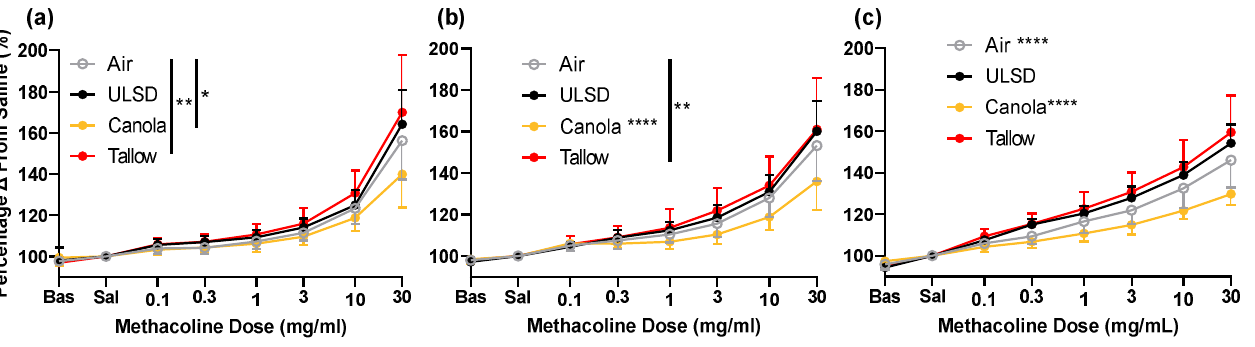
Figure 4. Responsiveness to methacholine for mice exposed to Air (A), ULSD (U), Canola (C), or Tallow (T) biodiesel exhaust for 2 h/day for 8 days. Data shown are ( a ) airway resistance, ( b ) tissue damping, and ( c ) tissue elastance for all exposure groups ( n = 12, except Air and ULSD where n = 11). Bas = baseline (FRC), Sal = saline. All data are shown as % change from saline (* = p < 0.05, ** = p < 0.01, **** = p < 0.0001, significant * values not located to the right of a line indicate that the group is significantly different to all other exposures). Data were analyzed using general linear modeling methodologies.